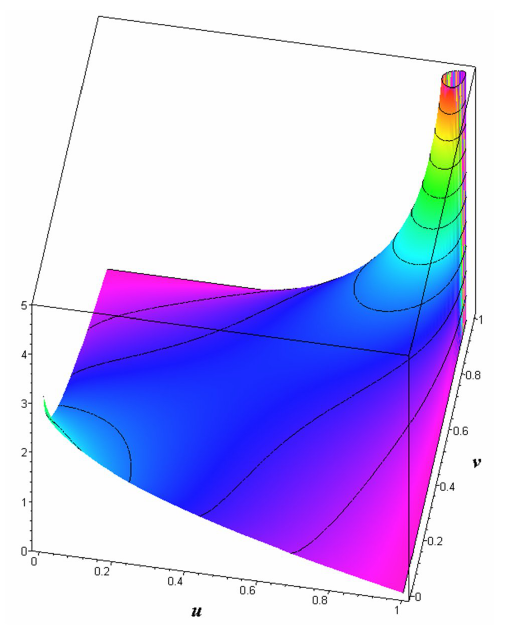
Figure 9: Symmetric Gamma copula density c Γ